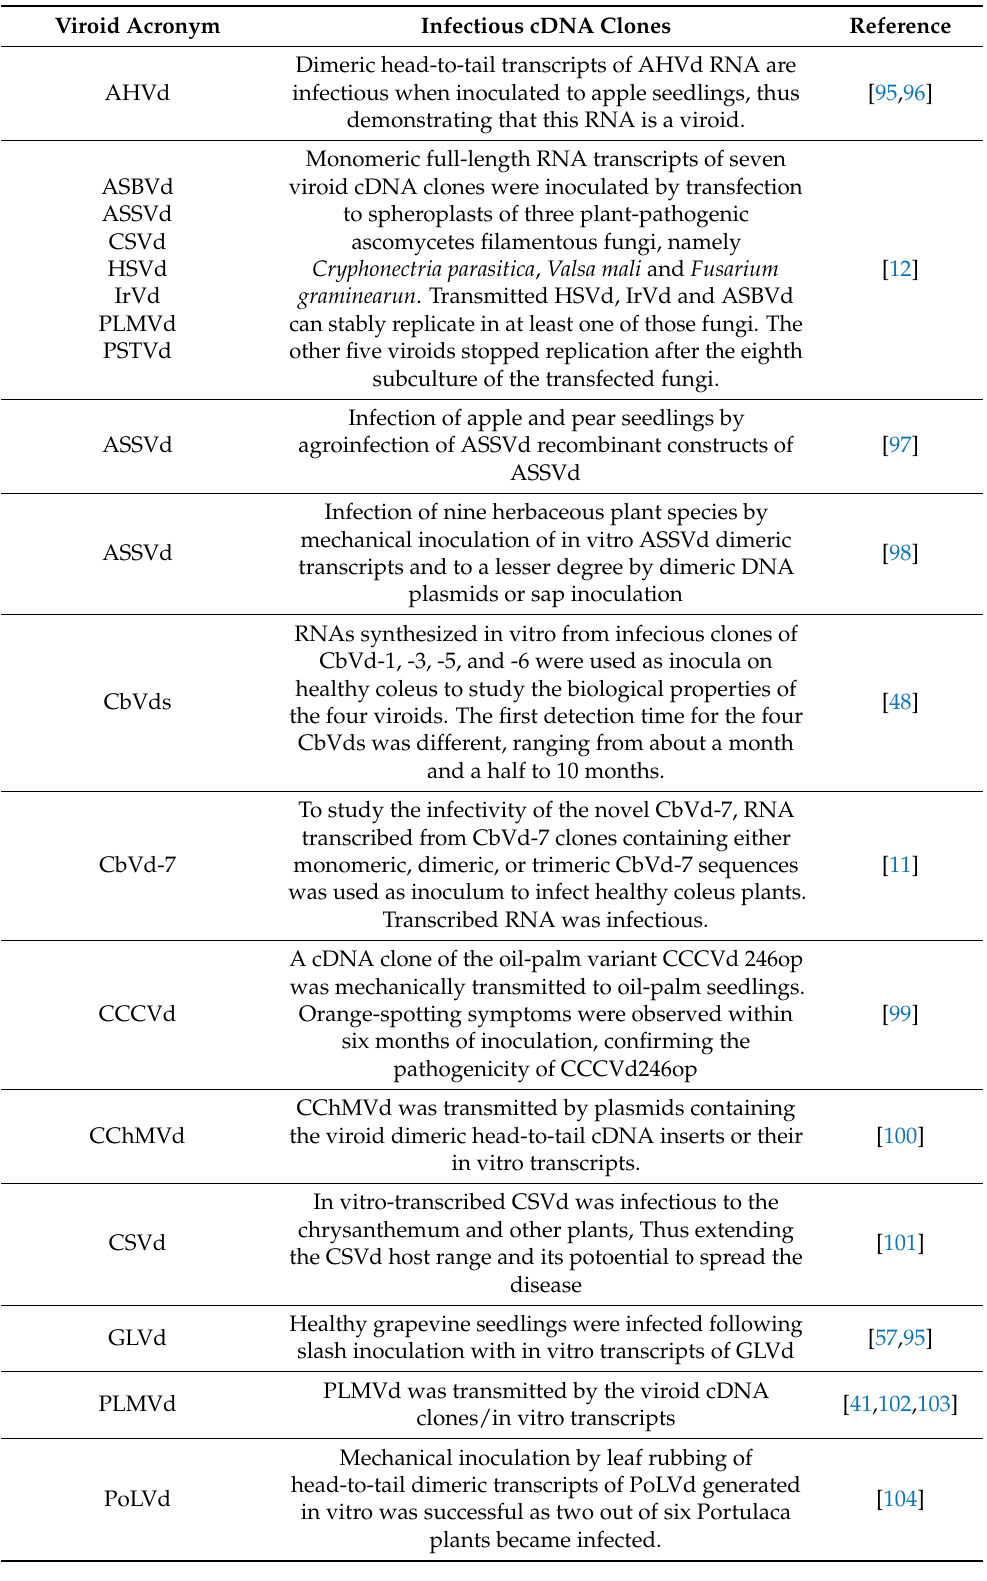
Table 3. Vector Transmission of Viroids by Infectious cDNA